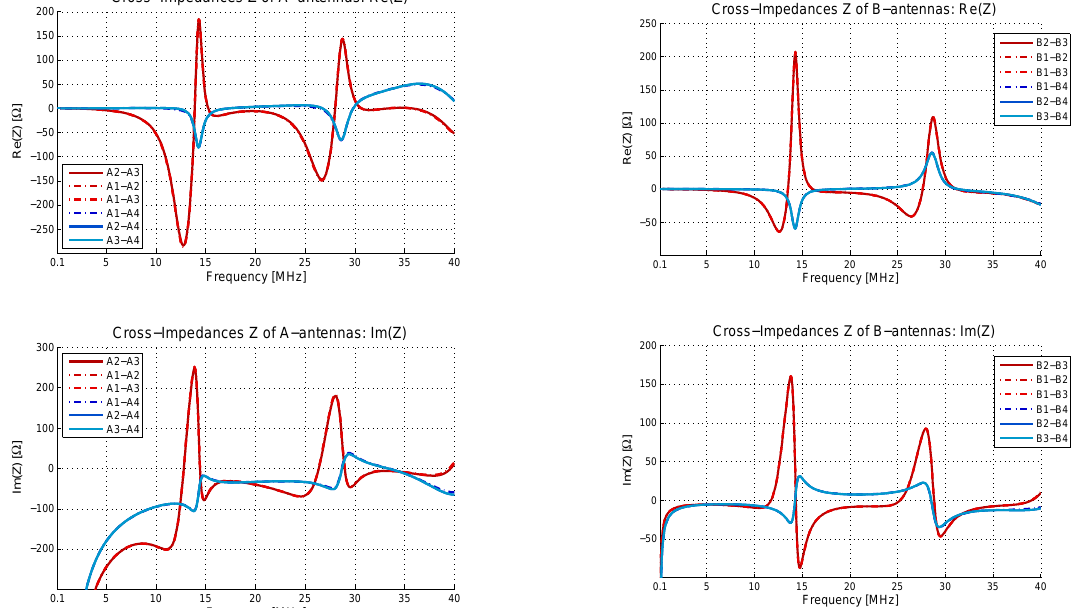
Figure 8. Mutual impedances of the boom antennas A 1– A 4 (left) and the short cylindrical sensors B 1– B 4 (right). The shown quantities are the off-diagonal elements of the impedance matrix Z , as a function of frequency. Upper panels contain the real parts, lower panels the imaginary parts. The red curves overlap due to the symmetry of the mounting of the booms A 1– A 3 and B 1– B 3. The same holds for the blue curves since A 4 and B 4 are in the symmetry axis of the